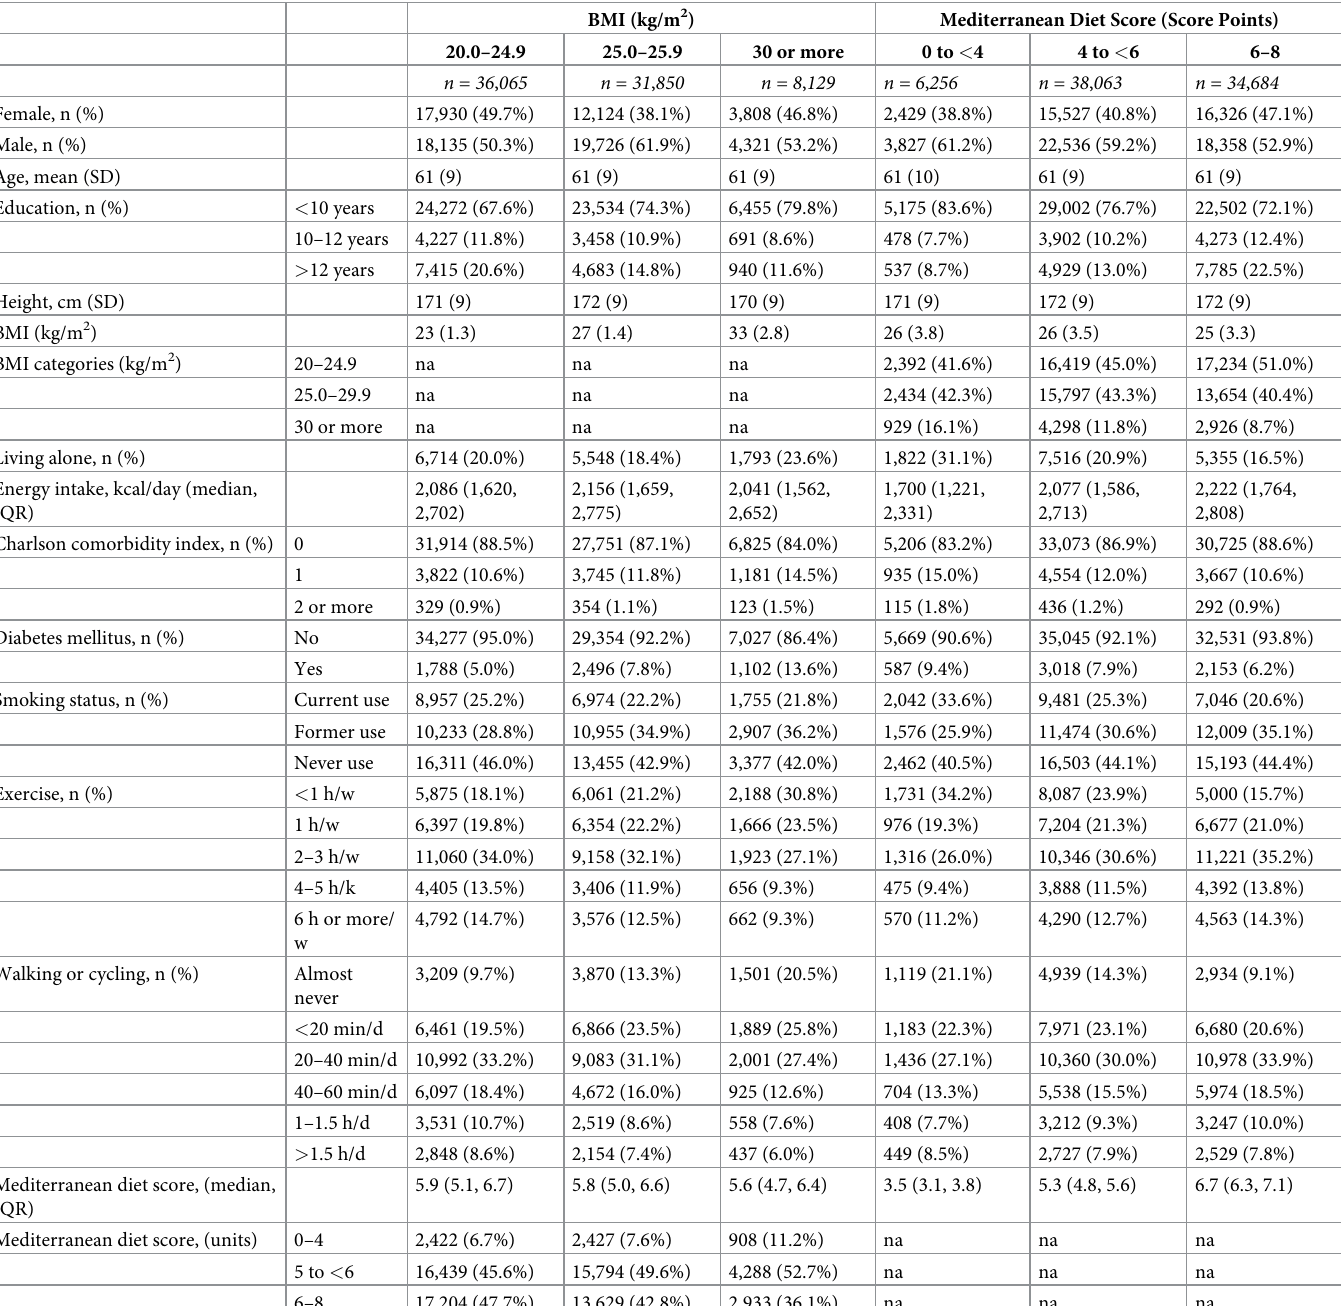
Table 1. Age-standardized baseline characteristics of the participants by 3 categories of BMI and 3 categories of Mediterranean diet score,